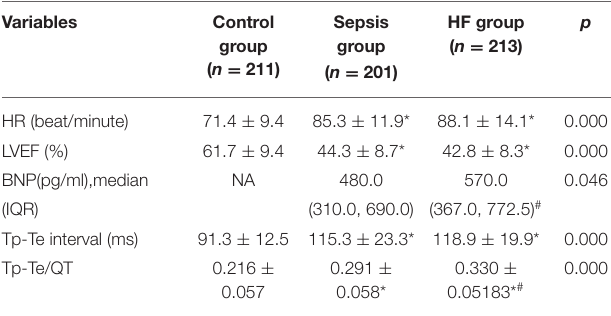
TABLE 1 | Baseline characteristics of participants. Characteristics